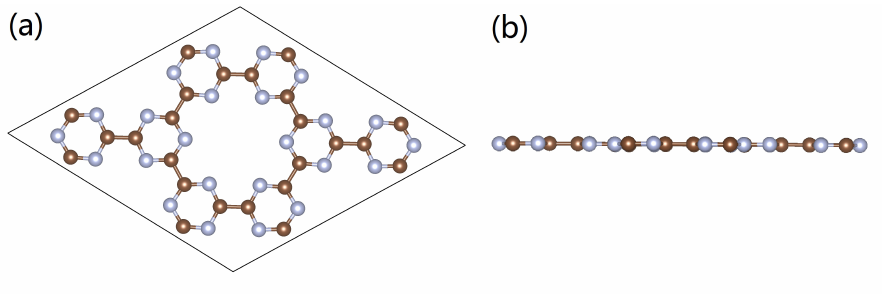
Figure 1. ( a , b ) Optimized configuration of the g-CN monolayer. Brown and silver spheres represent C and N atoms,